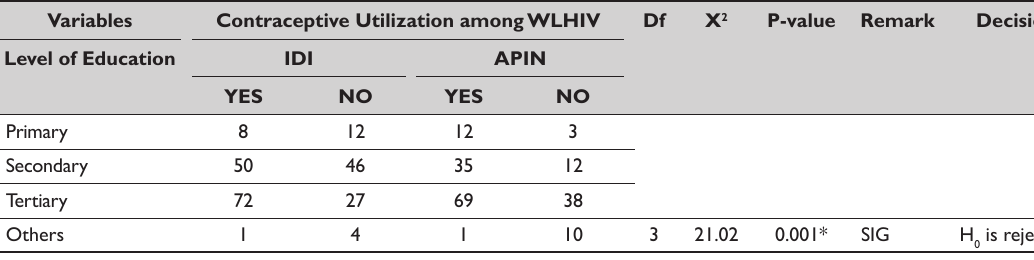
Table 7: Educational level and utilization of contraceptives among study participants Variables